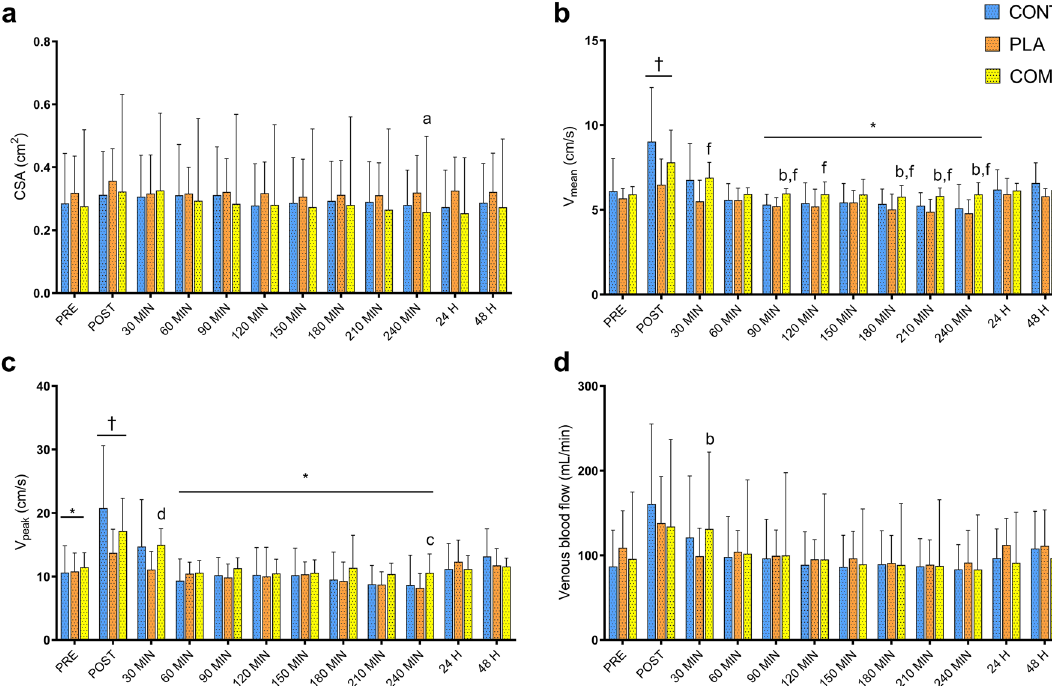
Figure 1. Popliteal vein markers of venous return for CON, PLA and COMP conditions. Markers measured include ( a ) cross-sectional area (CSA), ( b ) mean flow velocity (V mean ), ( c ) peak flow velocity (V peak ) and ( d ) venous blood flow. Time points are before exercise (PRE), immediately post-exercise (POST), 4 h recovery (30–240 min), and 24 and 48 h post-exercise. All data presented as mean ± SD. † Significant time effect as compared with all other time points. *Significant time effect as compared with 30 min post-exercise. a Small effect as compared with CON. b Medium effect as compared with CON. e Medium effect as compared with PLA. f Large effect as compared with